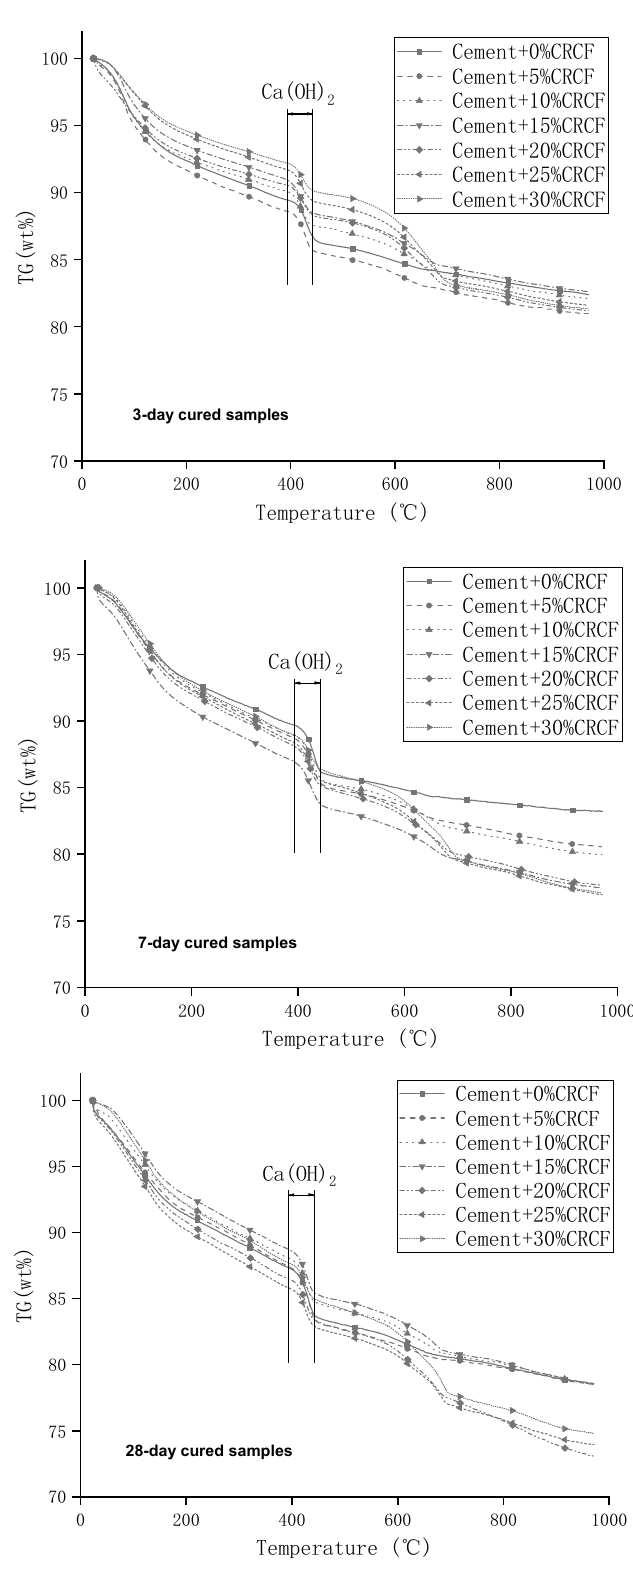
Figure 16. TG curves of the 3-day-, 7-day-, and 28-day-cured cement samples.